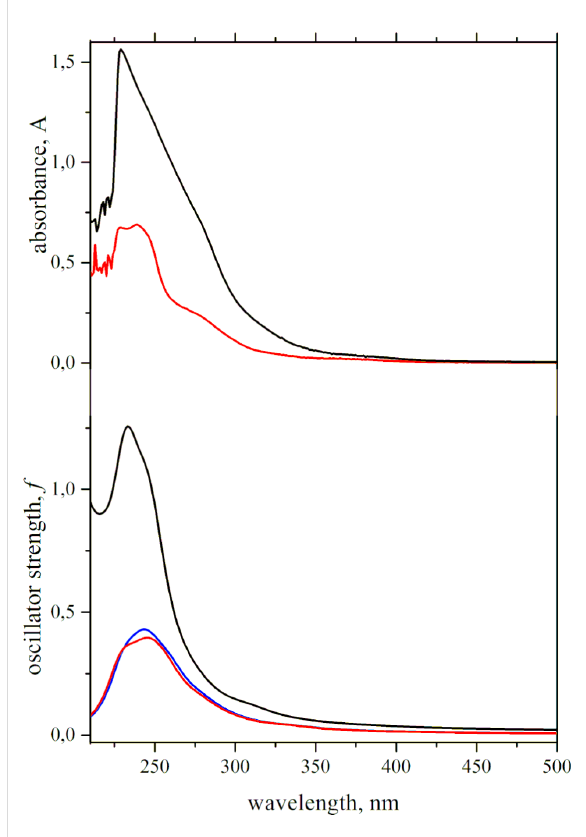
Figure 3: Top: experimental UV–vis spectra of 8 с (black) and 8b (red). Bottom: broadened calculated UV–vis spectra of 8c (black), 8b-I